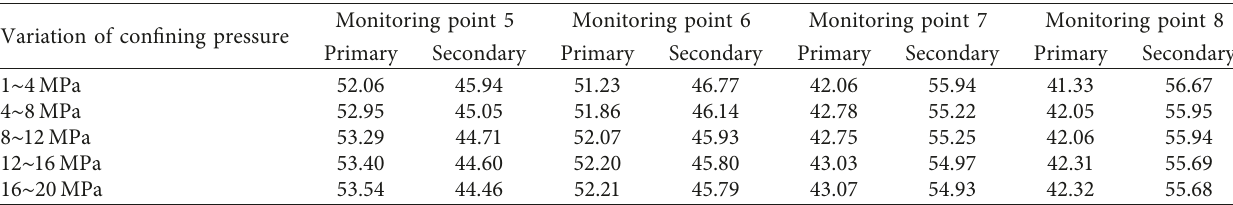
Table 4: Proportions of primary and secondary frequency bands in the increase amplitude of total energy in frequency bands at monitoring points 5 ∼ 8